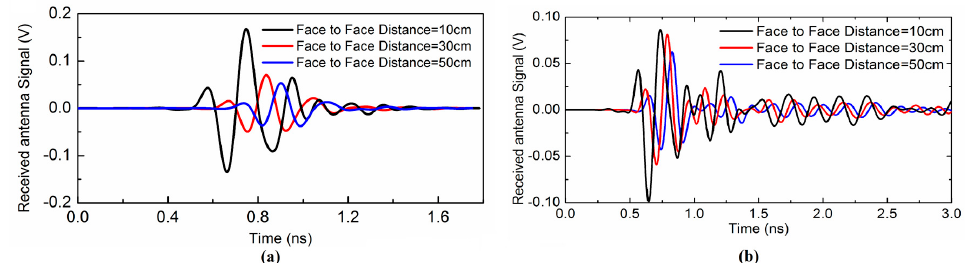
Figure 8. ( a ) Simulated received waveform of the reference antenna placed at three different positions ( b ) Simulated received waveform of the proposed antenna placed at three different positions.